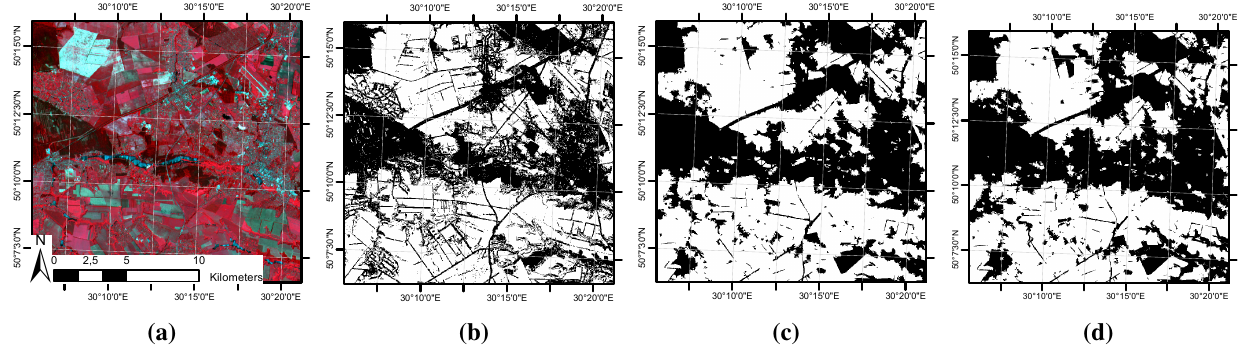
Figure 5. Spatial unit impact on cropland (in white) mapping. ( a ) The SPOT 4